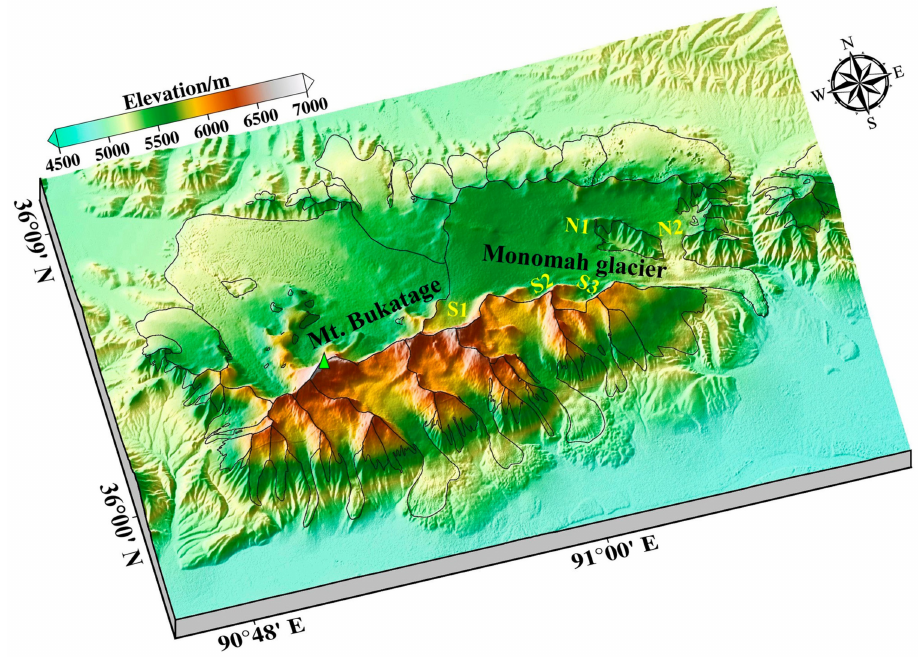
Figure 7. Topography of the Bukatage Massif. Elevation source: SRTM-C DEM; black lines: glacier boundary in